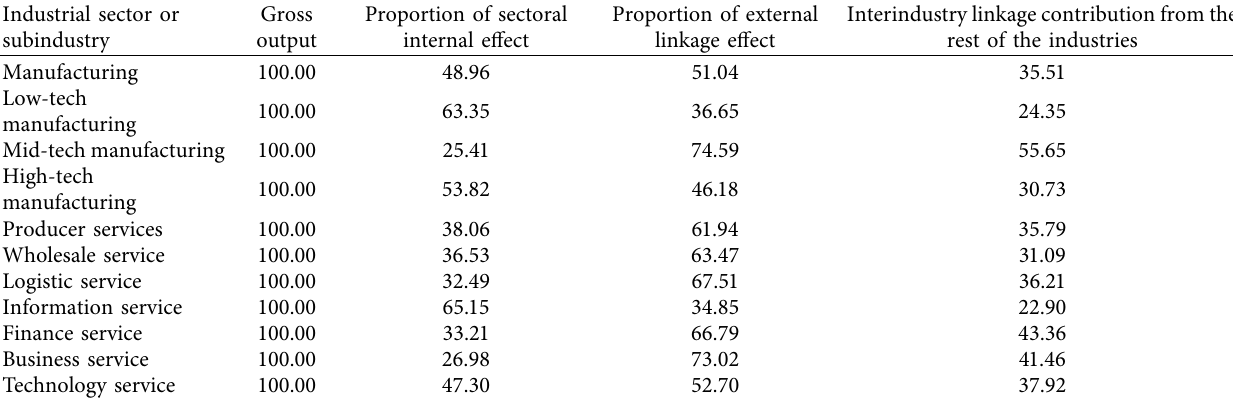
Table 4: Output structural features of manufacturing, producer services, and their subindustries.